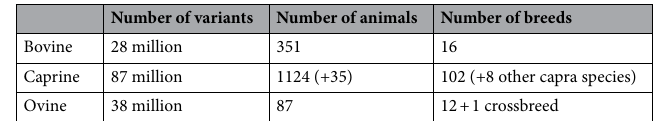
Table 4. Information on bovine, caprine and ovine genetic variants